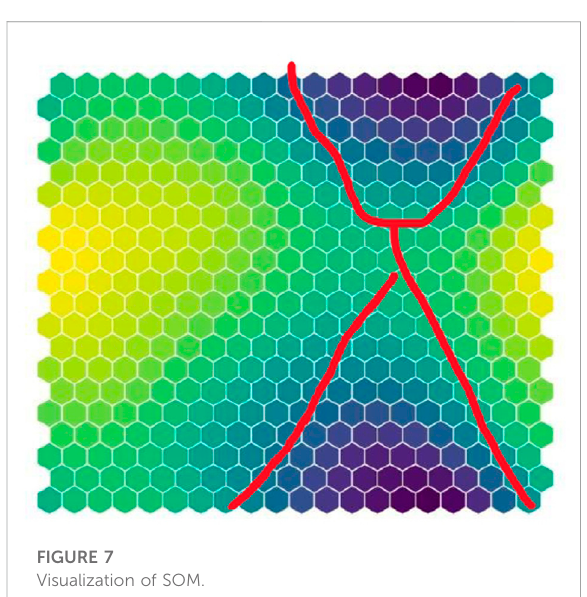
FIGURE 7 Visualization of